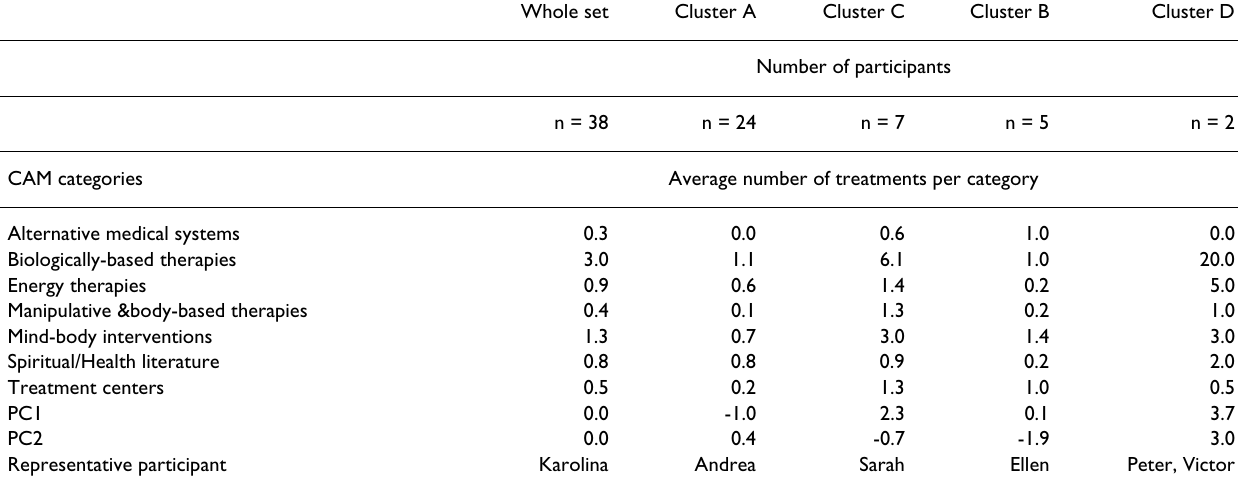
Table 5: Four clusters of rough user patterns.